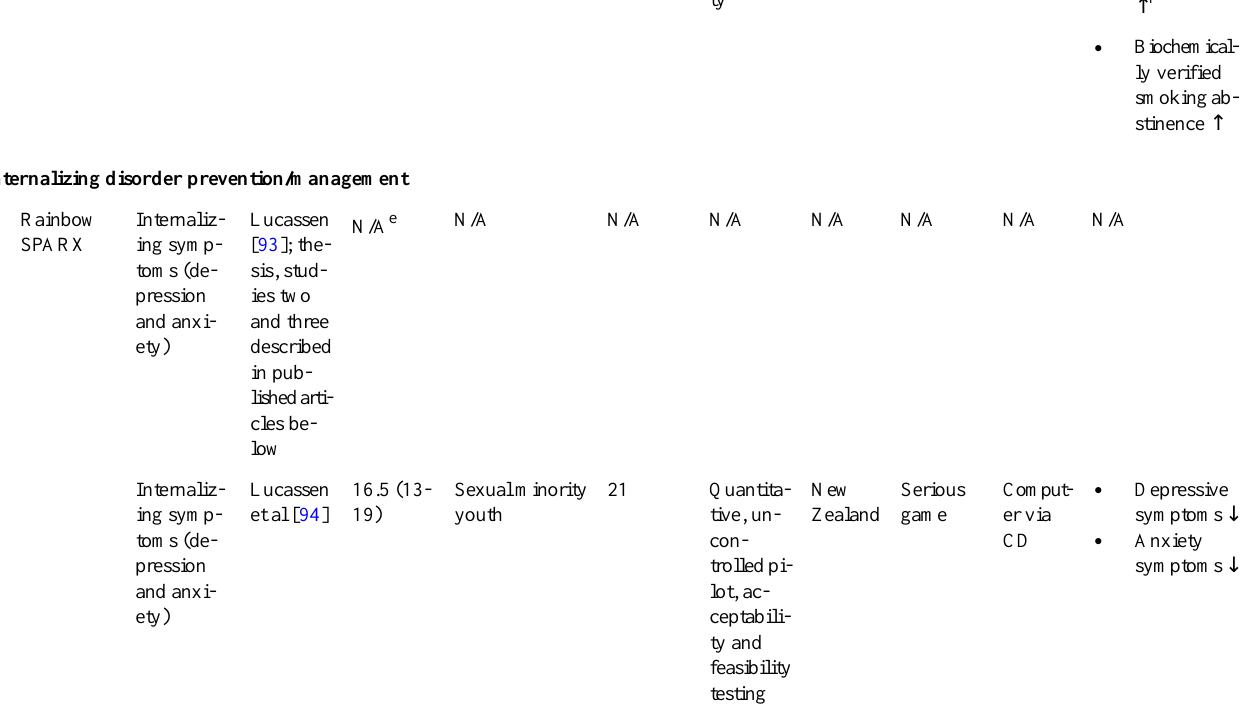
Primary mea- sured constructs